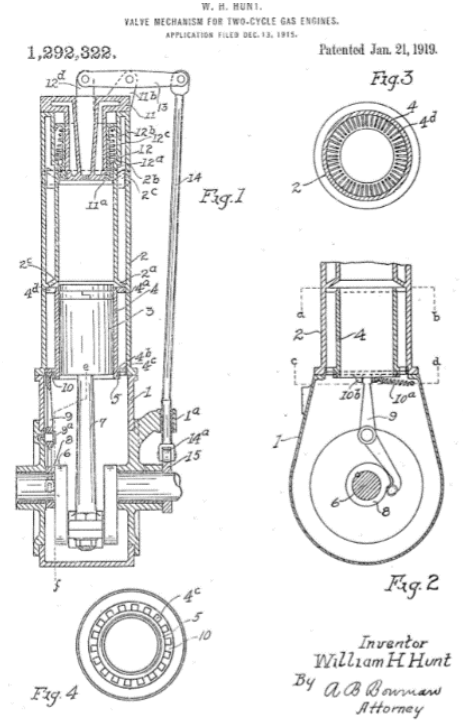
Figure 5. W.H. Hunt 13 December 1915, valve mechanism for two-stroke gas engine US 1292322. Reproduced with permission from US Patent. Copyright Publisher, 1919.